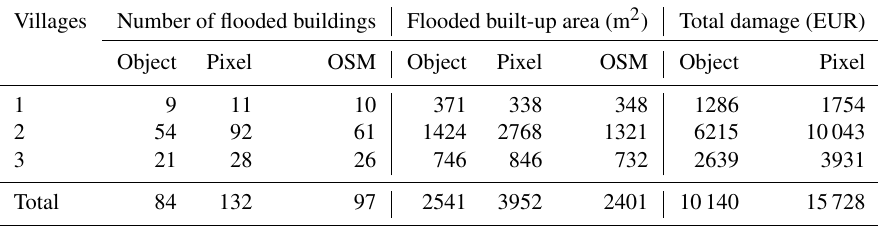
Table 7. Flooded buildings and built-up area according to (1) the object-based approach, (2) pixel-based approach and (3) the available OSM map, as well as area and total damage according to (1) the object-based approach and (2) pixel-based approach.